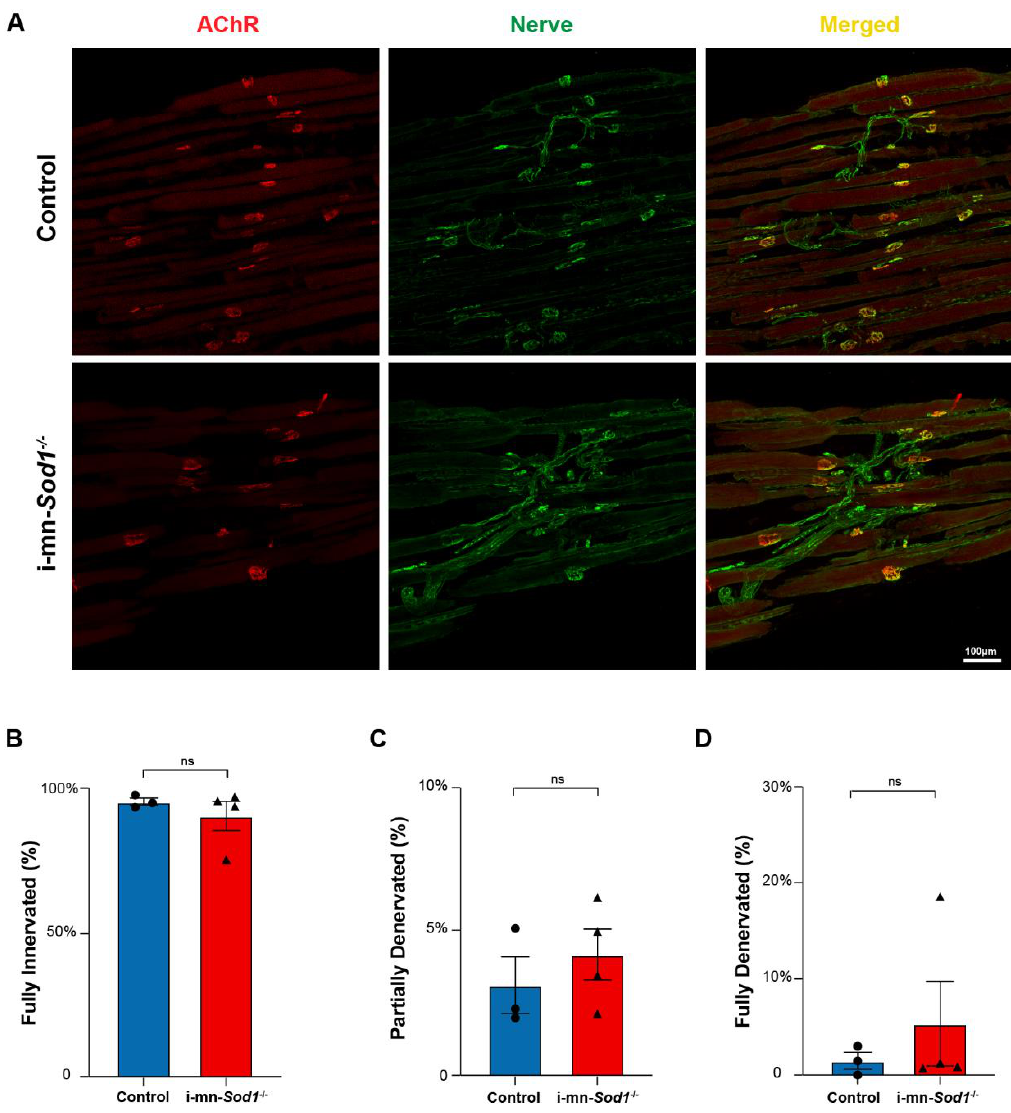
Figure 6. NMJ morphology in control and i-mn- Sod1 -/- mice. ( A ) Representative immunofluorescent images of NMJs in lumbrical muscles of 20-month-old control and i-mn- Sod1 -/- mice. Muscles were stained for nerve with anti- βIII Tubulin antibody (green) and acetylcholine receptors, AChR with BTX (red) to visualize pre- and post-synaptic structure, respectively. Scale bar (100 µm) is labeled in image. Data are shown for the number of ( B ) fully innervated, ( C ) partially denervated, and ( D ) fully denervated endplates for control (n = 3, blue, circle) and i-mn- Sod1 -/- (n = 4, red, triangle) mice. Data in B – D are presented as mean+SEM including individual data points and analyzed b y Student’s t -test. There were no differences between any groups.